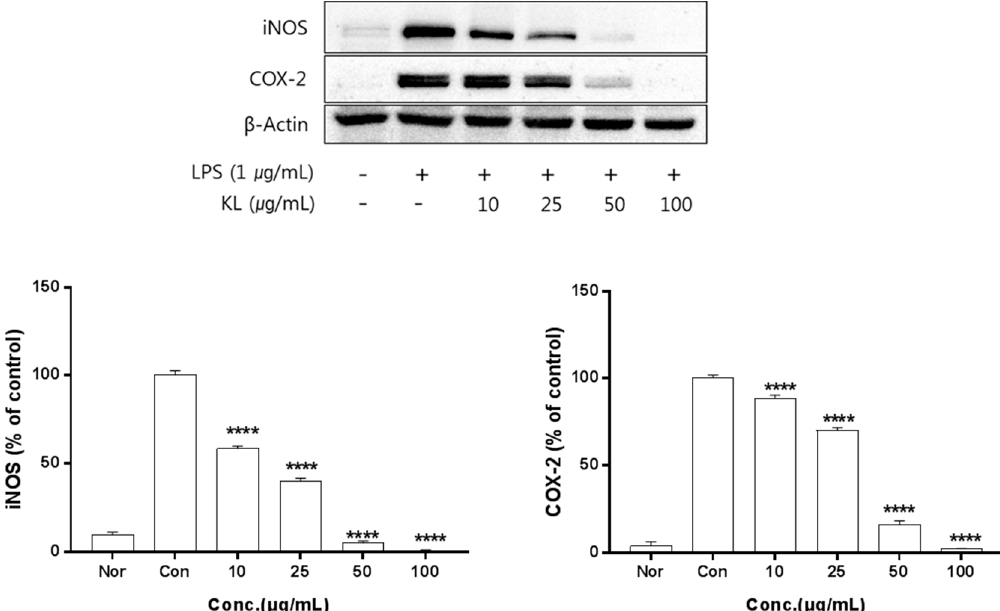
Figure 2. Inhibitory effects of KL on iNOS and COX-2 production in LPS-stimulated Raw 264.7 cells. Equal amounts of cell lysates (30 µ g) were subjected to electrophoresis and analysed for inducible nitrix oxide synthase (iNOS) and COX-2 production by Western blot. Raw 264.7 cells were incubated with LPS (1 µ g/mL) and KL extract for 24 h. Each value is expressed as mean ± SD of three independent experiments. **** p < 0.0005 as analyzed by Duncan’s multiple range test. Nor: normal; Con: control.